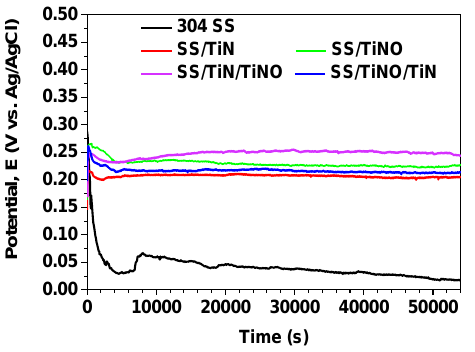
Figure 4. Open circuit potential (E oc ) evolution during the 15 h immersion in 0.10 M NaCl + 1.96 M H 2 O 2 at 37 ± 0.5 °C.